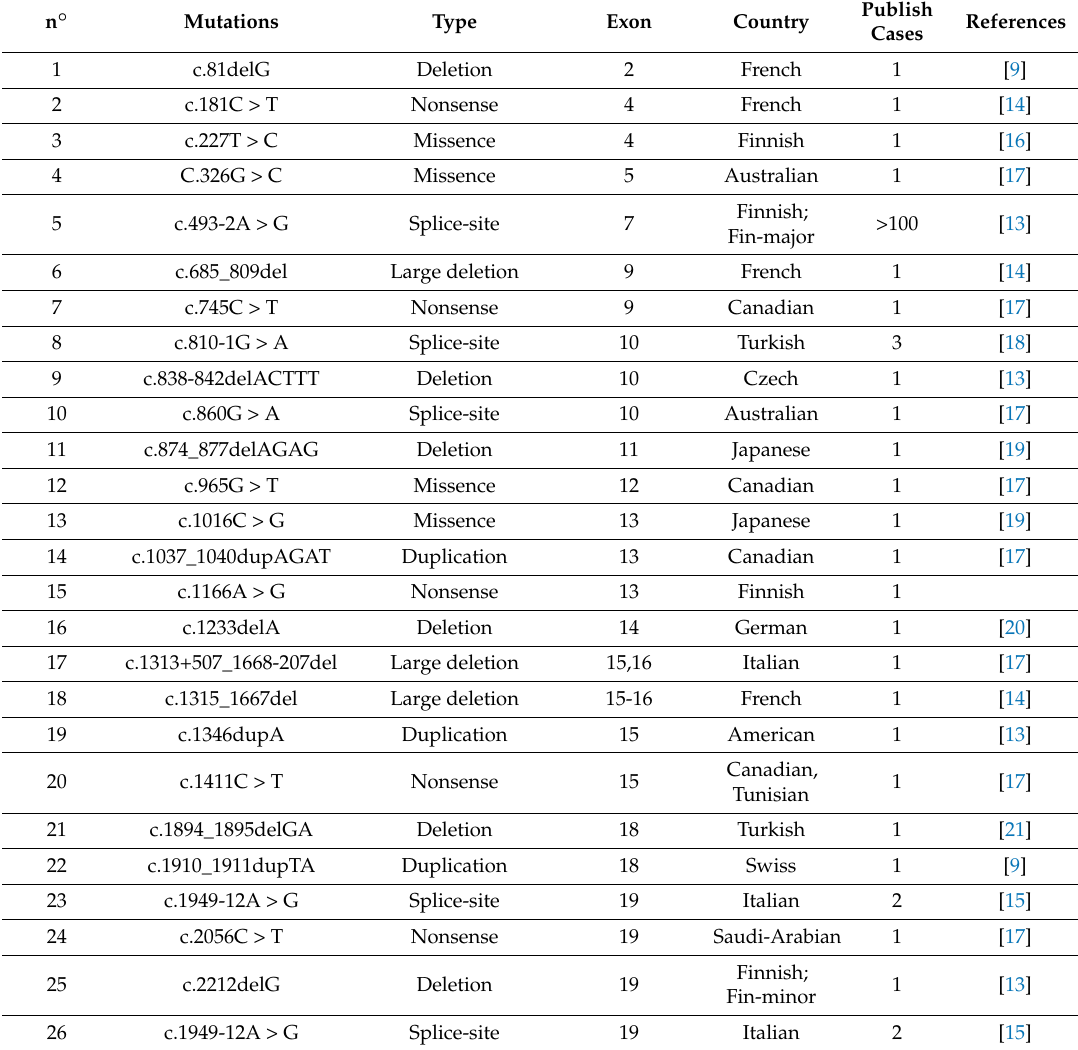
Table 1. Summary of the mutations with genomic localization, geographical origin, and references. n